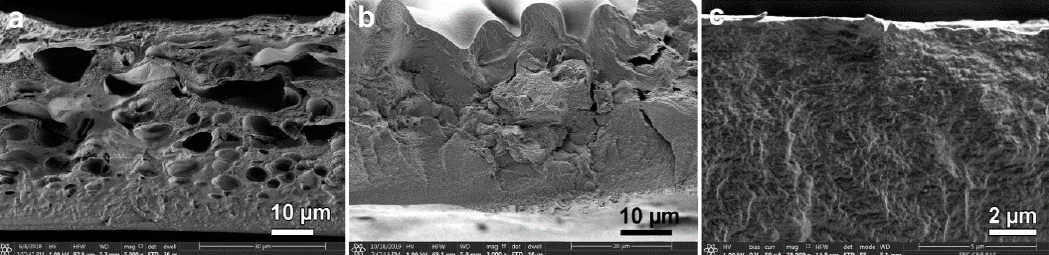
Figure 10. SEM microphotographs of the cross-section of dry cellulose film: spun in IBA at 25 °C ( a ); after coagulation in IPA at 25 °C and further washed in water ( b ); and after coagulation in water at 25 after coagulation in IPA at 25 ◦ C and further washed in water ( b ); and after coagulation in water at °C, washing in water and drying ( c ). 25 ◦ C, washing in water and drying ( c